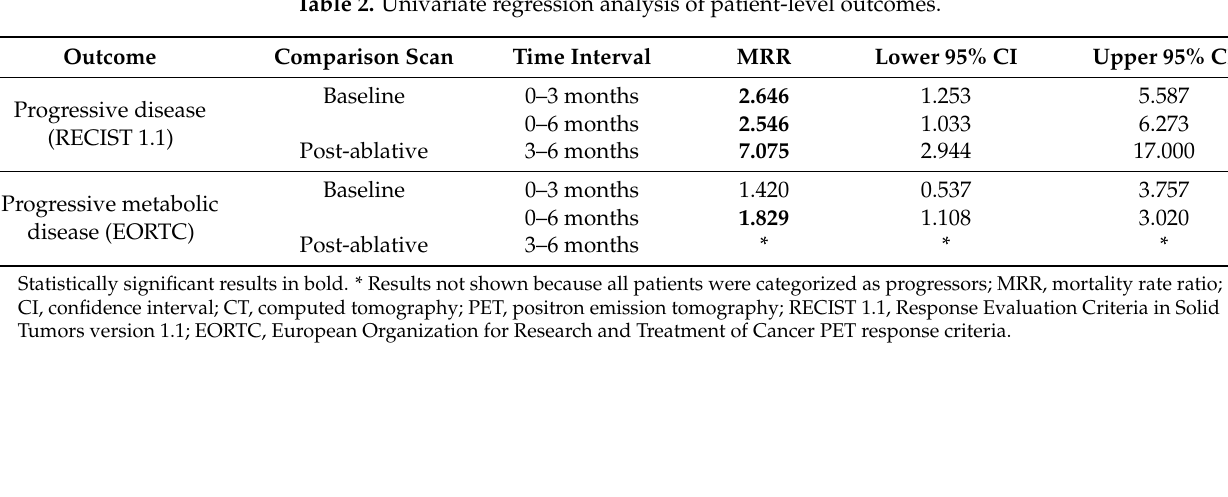
Table 2. Univariate regression analysis of patient-level outcomes.